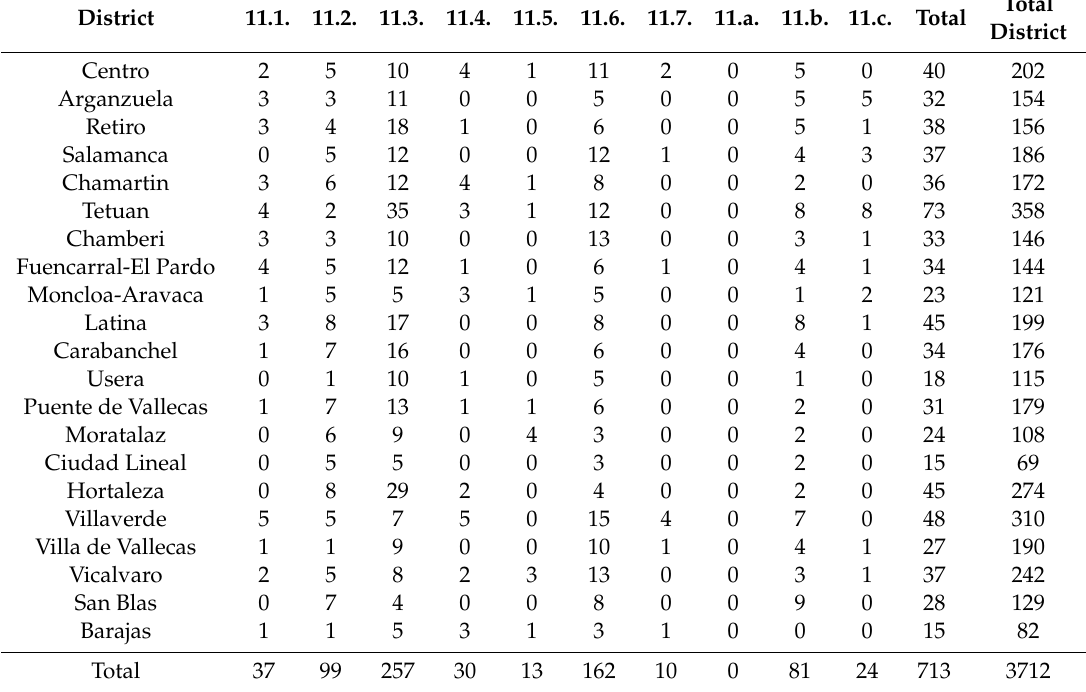
Table 5. Sharing of actions between targets of SDG # 11 (Source: author).